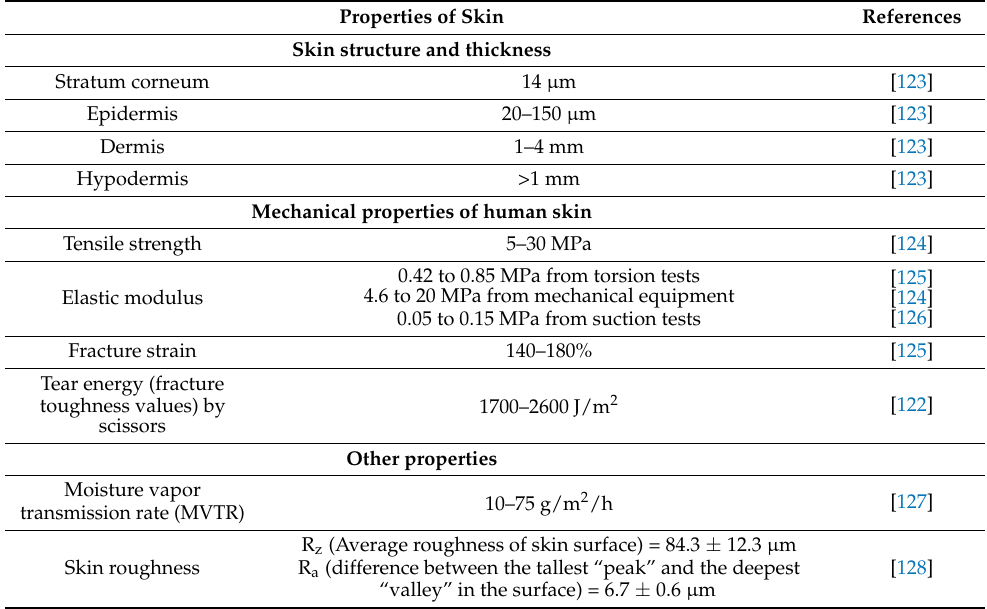
Table 3. Important properties of